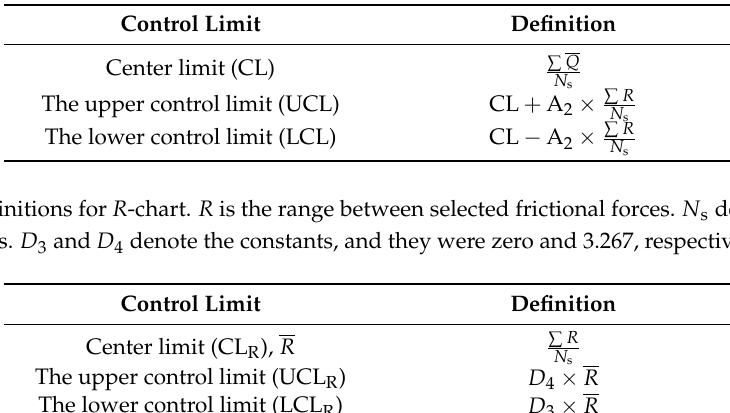
Table 2. Definitions of control limits for the average frictional force chart. Q and N s denote the average frictional force and the number of subgroups, respectively. A 2 is 1.88 for two sample sizes. R is the difference between selected frictional forces.